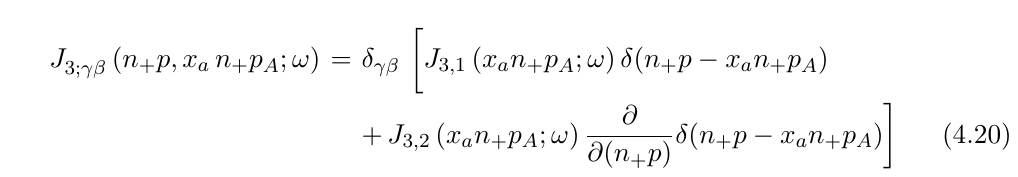
+ term in (2) , are reproduced by the two parton B L